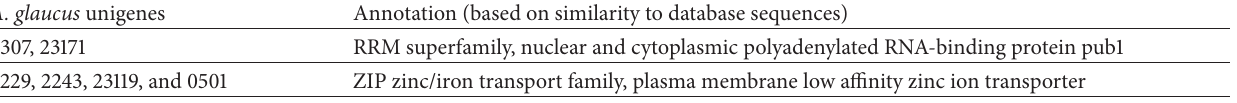
Table 2: A. glaucus coding sequences expressed during growth on 3 M NaCl. One hundred cDNA clones were randomly selected and